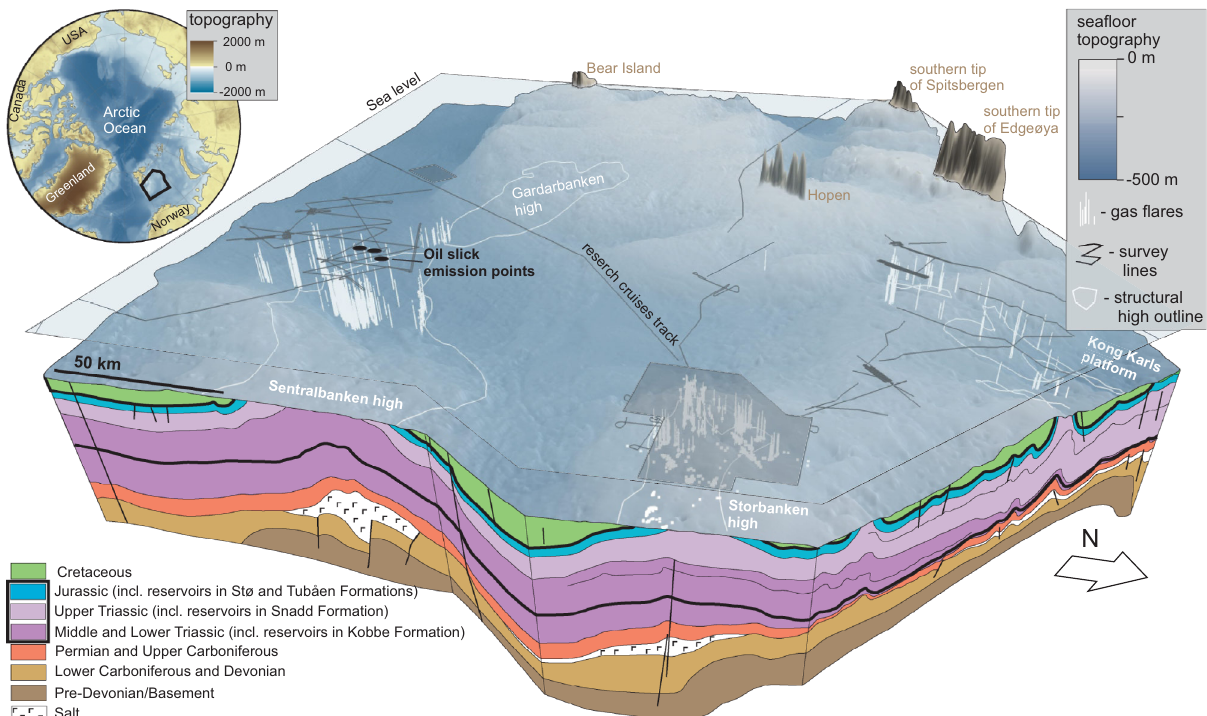
Fig. 7 | Exhumed hydrocarbon-bearing structures in the northern Norwegian Barents Sea emitting gas and oil to the water column. Subvertical white stripes and white dots show gas seeps. Shaded polygons on the sea surface show aerial multibeam echosounder data coverage. White polygons indicate structural